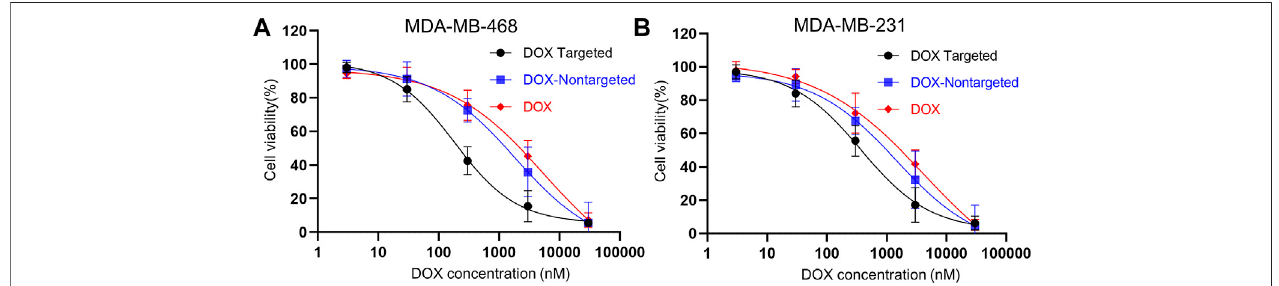
FIGURE 7 | (A) Dose-dependent cytotoxicity of MDA-MB-468 cells and (B) MDA-MB-231 cells incubated with DOX-loaded targeted origami (black), DOX-loaded nontargetedorigami(blue),freeDOX(red)for24 h.AlltheplotsshowedasigmoidaldecreaseinviabilitywithincreasingDOXconcentrations.ForMDA-MB-468cells,the IC50 values for DOX loaded targeted origami, DOX loaded nontargeted origami and free DOX were 182 nM, 1861 and 5740 nM, respectively. For MDA-MB-231 cells, the IC50 values for DOX loaded targeted origami, DOX loaded nontargeted origami and free DOX were 371 nM, 1440 nM and 4188 nM, respectively This implied higher ef fi cacy of folate-targeted DOX delivery was achieved with DOX-loaded folate-functionalized DNA origami